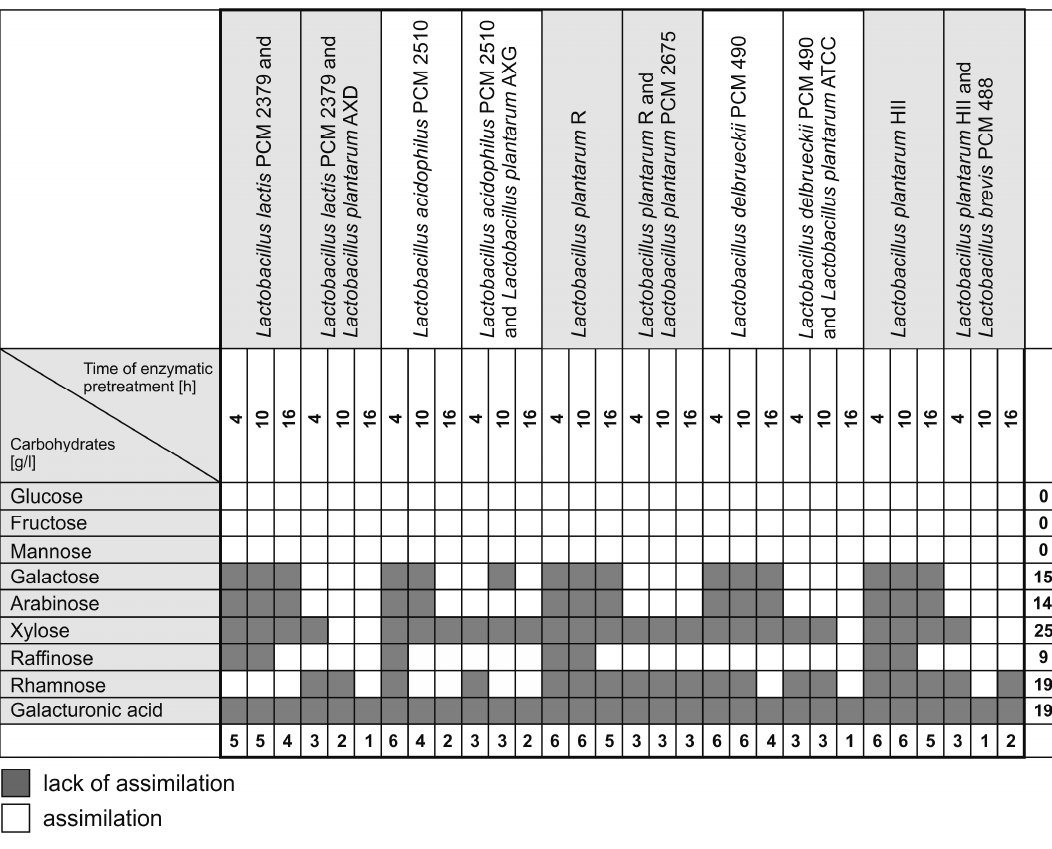
Figure 1. Assimilation profiles for the first and second steps of the SSF processes.